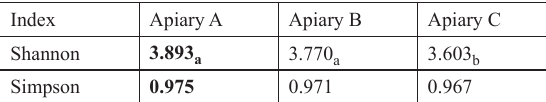
Values followed by the same letters, in the same line, did not differ among themselves at the level of 5% of